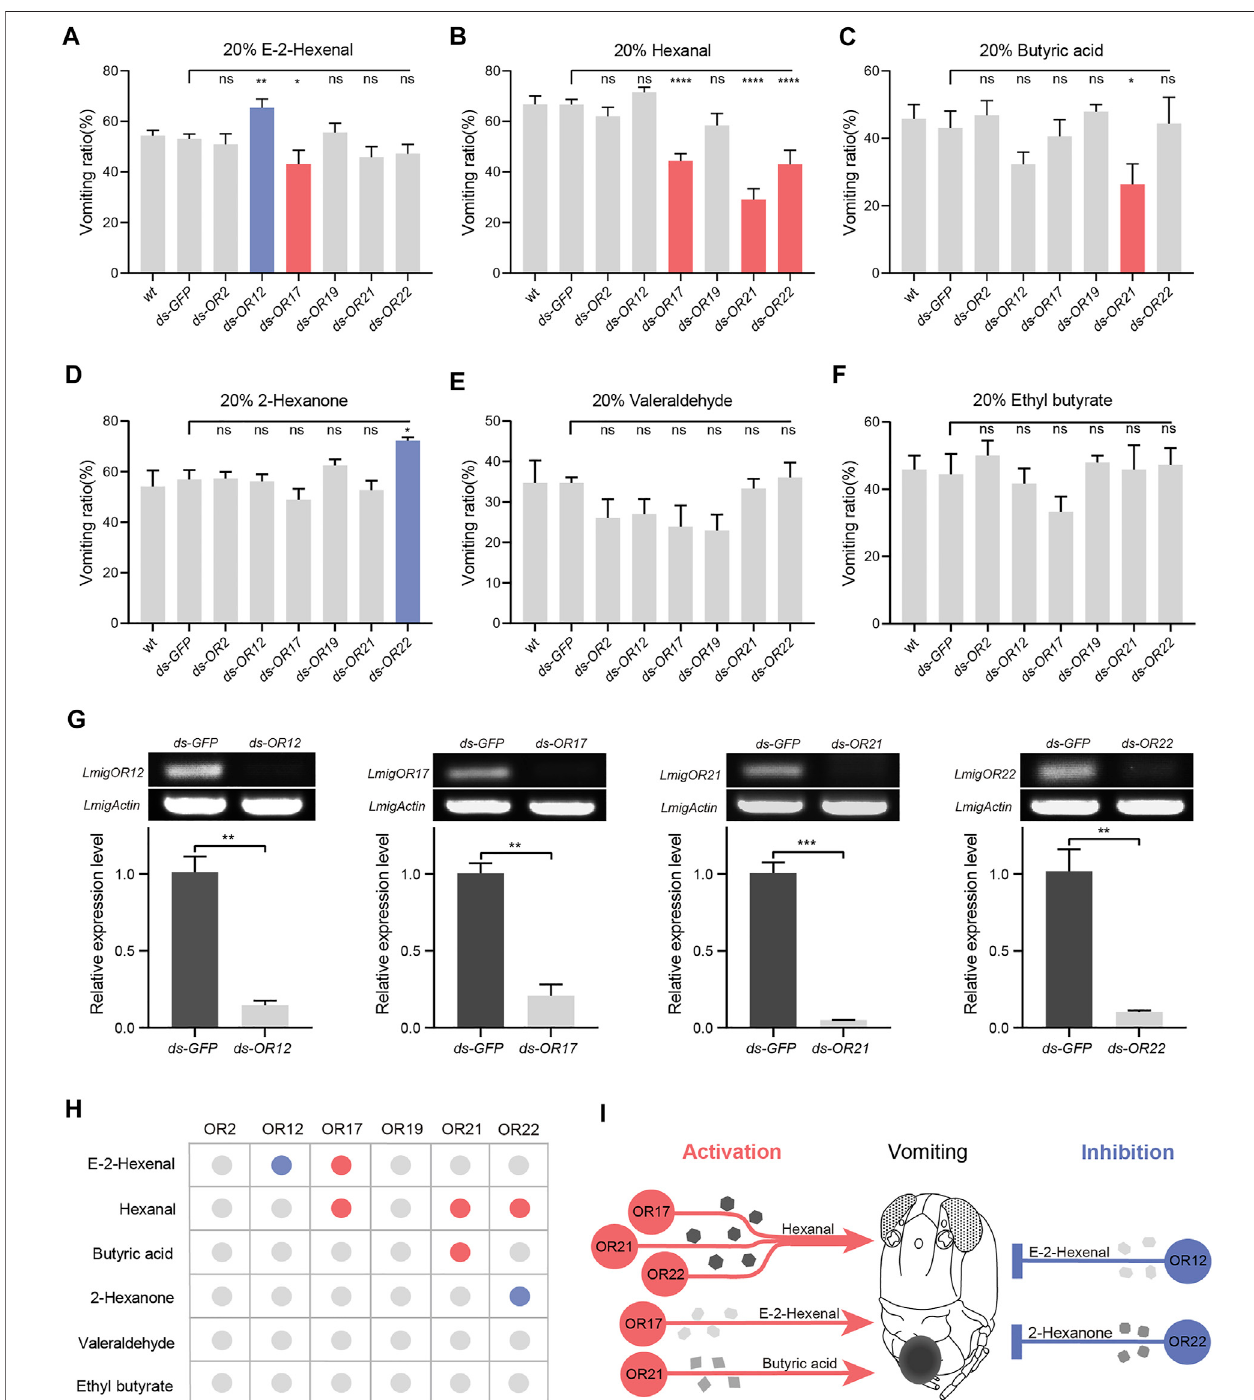
FIGURE3| Odorantreceptorsareinvolvedintheactivationorinhibition oflocustvomiting. (A – F) Vomitingresponseassaystowardmultiplecompoundswithwild- type locusts and locuststreated withdsRNA ofGFP or an individual OR. n = 3 – 6(24 locusts per replicate) for each assay. Statistical test: ordinary one-way ANOVA with uncorrectedFisher ’ sLSDtest. (G) EffectsofRNAiagainstOR12,OR17,OR21,andOR22, n =3.Statisticaltest:unpairedtwo-tailedt-test. (H) Tablelistingtheregulation modes ofpalpal ORson locustvomiting response. The blue dot indicates inhibition, the orange dot indicates activation, and thegray dot indicates noresponse. (I) Schematic diagram of locust vomiting response regulated by ORs in two modes: inhibition and activation. For all analyses, statistical differences are represented as follows: ns, not signi fi cant, * p < 0.05, ** p < 0.01, *** p < 0.001, and **** p < 0.0001. Data are represented as the mean ± SEM.